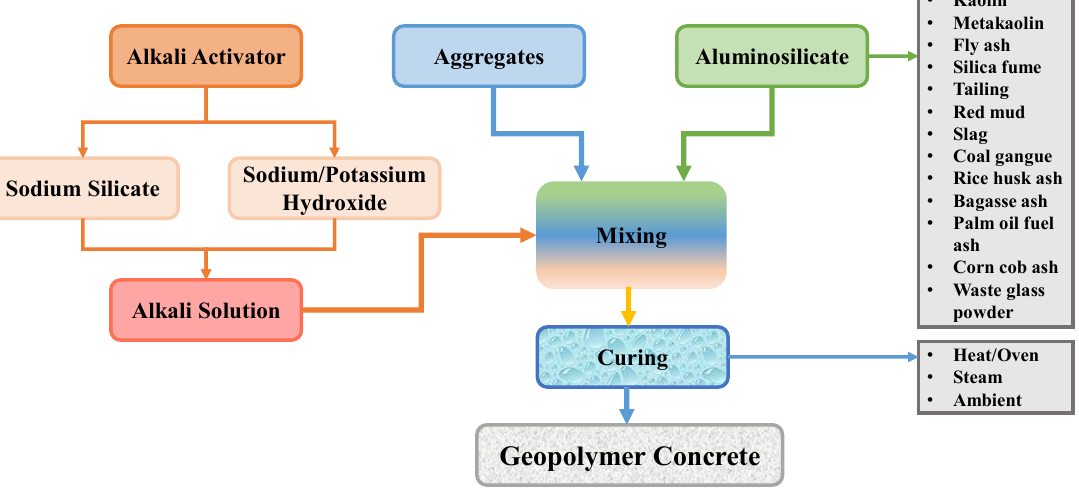
Figure 1. Production process of geopolymer concrete.